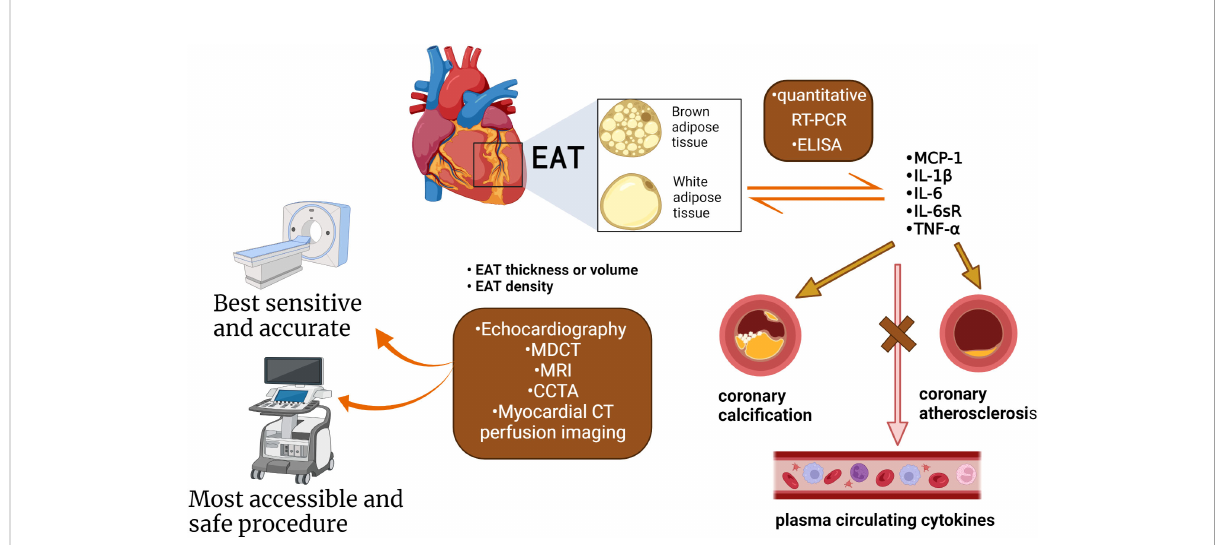
FIGURE 4 The methods used to measure the quantity and quality of EAT. Quanti fi cation of EAT has seen improvements over the years attributed to the advancements in non-invasive imaging techniques: CT, as well as CMR, PET. Evaluation indicators as thickness, volume, and density. EAT under chronic in fl ammation shifts from brown fat to white fat. The quality of the EAT was changed, such as in fl ammatory status, the type of adipokines, and microRNA. The cytokines and adipokines within the EAT can be measured by quantitative RT-PCR and ELISA. Cytokines correlate with the presence of CAD, severity, and coronary artery calci fi cation, but not with circulating cytokines in plasma. EAT in fl ammation was independent of several clinical variables (obesity, diabetes, or chronic therapy with statins or ACE inhibitors). (Created with